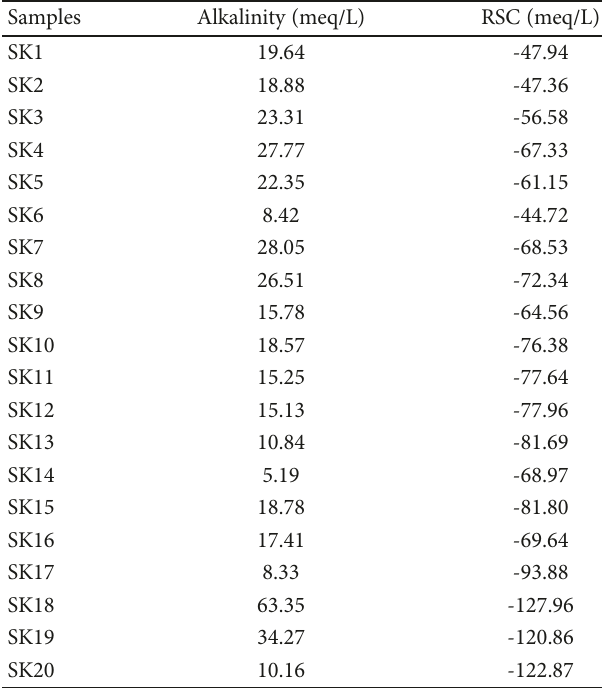
Table 9: Alkalinity and residual sodium carbonate (RSC) of selected groundwater